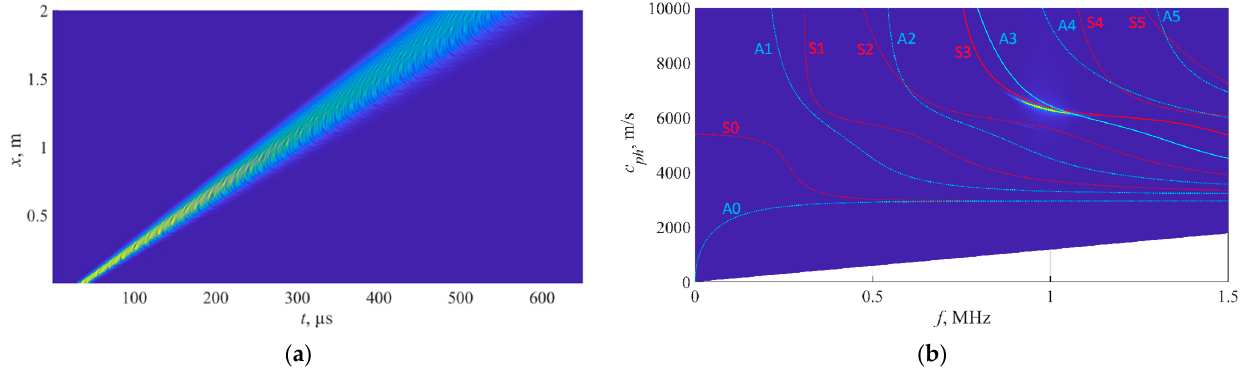
Figure 12. Signals in case of excitation with apodization from both sides: ( a ) B-Scan from top side of the plate; ( b ) reconstructed phase velocity dispersion curves.